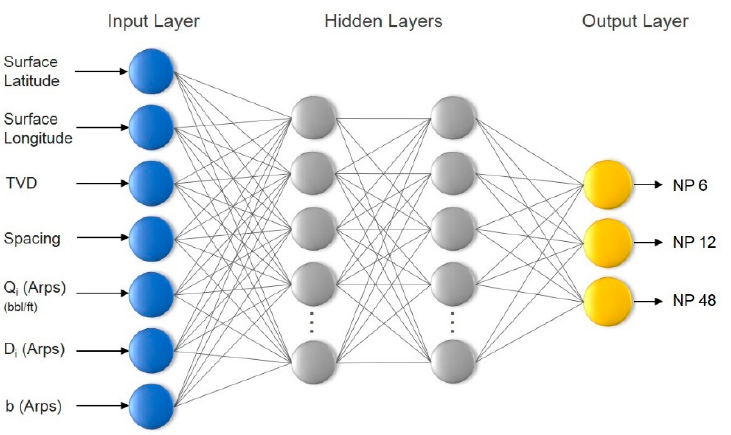
Figure 22. Structure of the ANN model in this study.